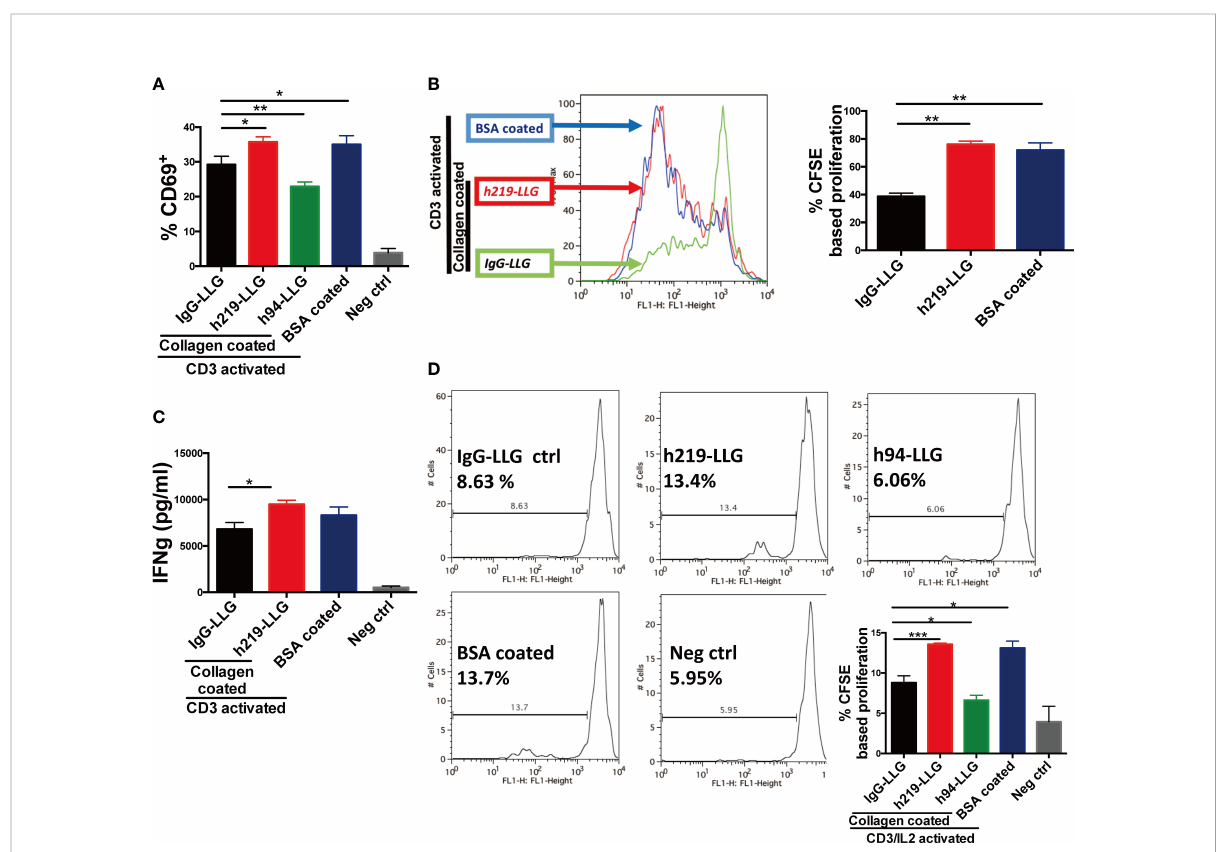
FIGURE 2 Inhibition of LAIR1 enhances primary T cell activation and proliferation. (A-C) Anti-LAIR1 h219 promoted T cell activation in human PBMCs stimulated with 1 m g/ml anti-CD3 antibody (OKT3). Cell surface CD69 was detected at 12 hours (A) . CFSE based CD3 + cell proliferation was detected on day 3 (B) . IFN- g secretion was detected by ELISA on day 5 (C) . (D) h219 promoted activation of puri fi ed T cells. Pan T cells were activated with 1 m g/ml anti-CD3 antibody (OKT3) and IL2. CFSE based T cell proliferation was detected on day 3. In (A) one-way ANOVA test for IgG-ctrl, h94, and h219, p<0.0006. In (D) one-way ANOVA test for IgG-ctrl, h94, and h219, p<0.0001. As Statistical Analysis in Methods stated: * indicates p < 0.05; ** indicates p < 0.01, *** indicates p <